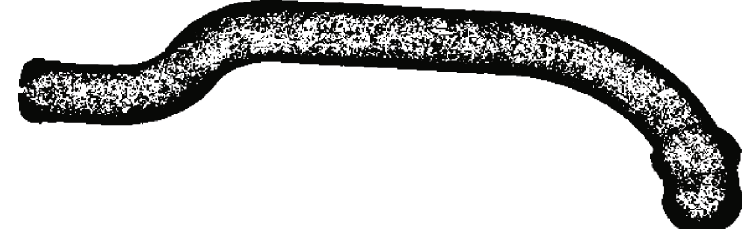
Figure 5: Simulation result of water fi lling.